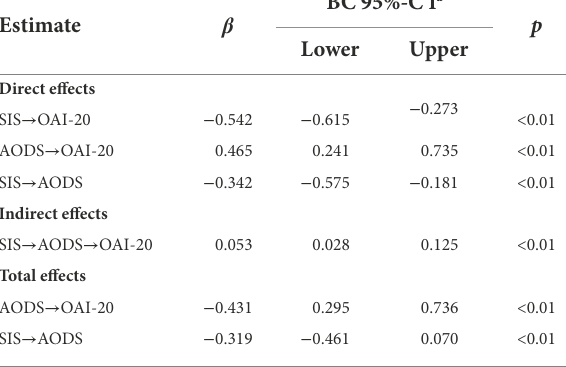
TABLE 6 The direct effects, indirect effects, and total effects of each path in the model.